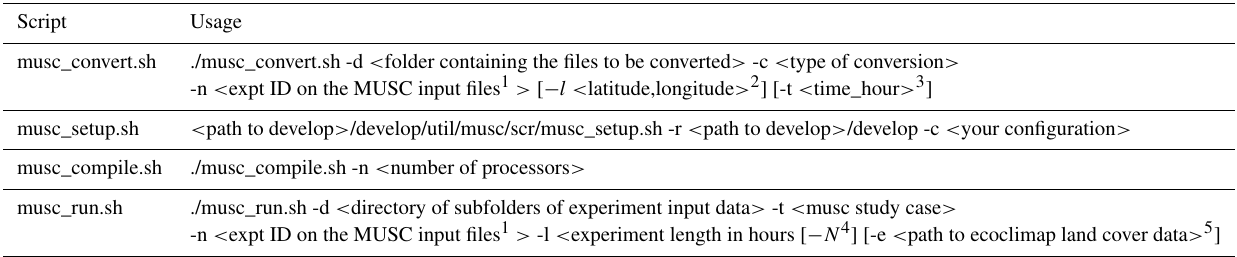
Table A1. MUSC script